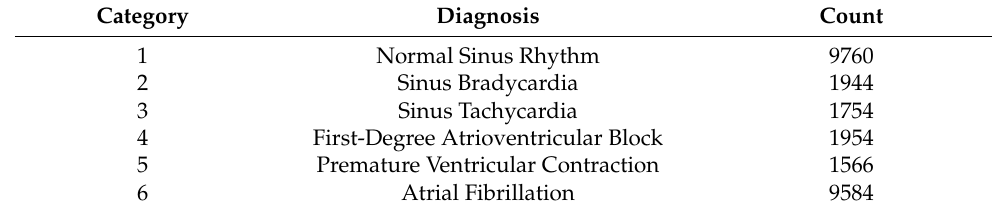
Table 1. Categories: Normal vs. Arrhythmia.